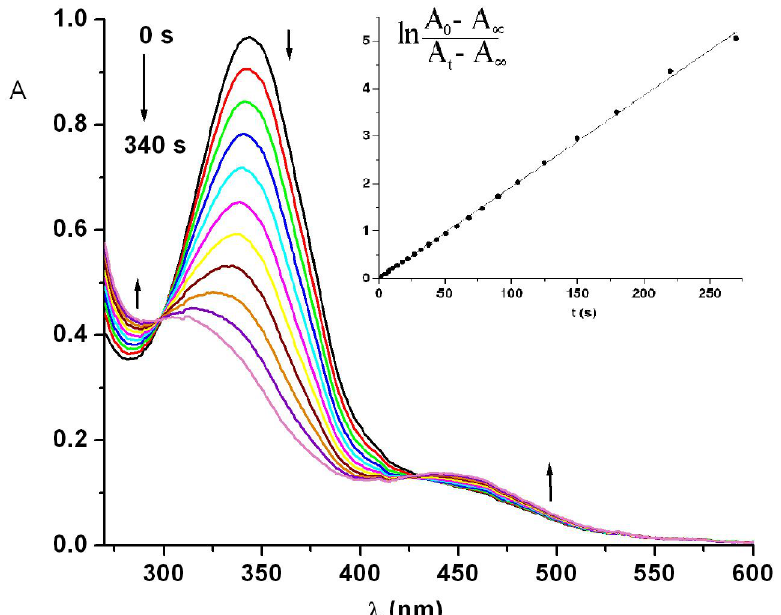
Figure 8. Photoisomerization of azopolythioetherimide (PTEI) in DMF solution upon irradiation at 365 nm. Inset indicates the trans-cis photoisomerization